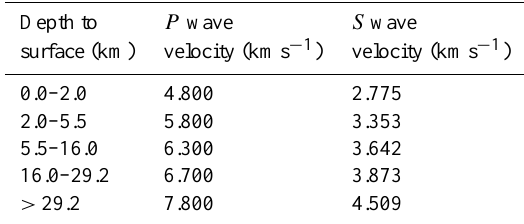
Table 1. The starting 1-D velocity model ( m 0 ) used in this